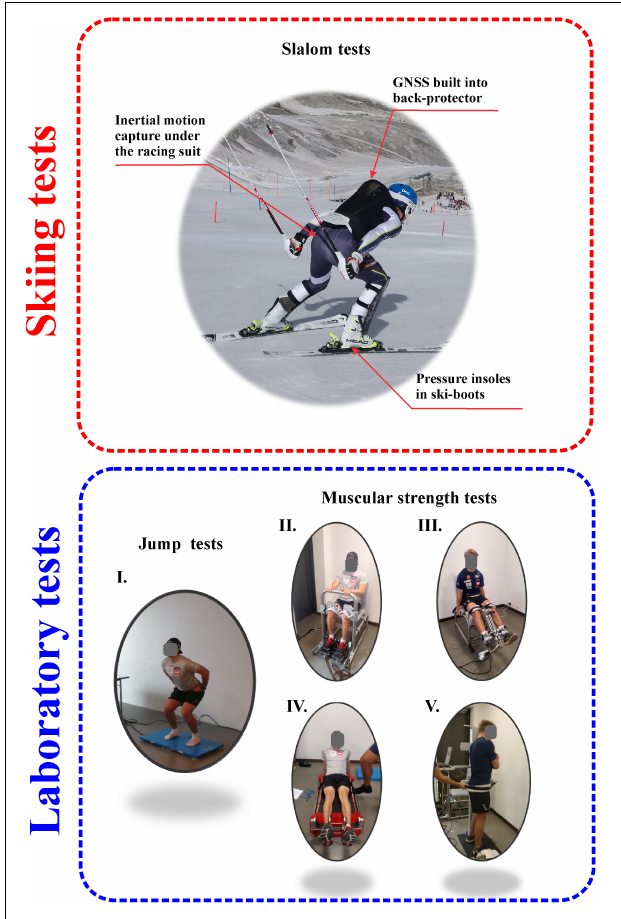
FIGURE 1 | Setups for the skiing measurements on snow (top) and laboratory tests (bottom): (I) countermovement jump on a bilateral force platform, (II) ankle dynamometry, (III) knee dynamometry, (IV) hip dynamometry, and (V) trunk